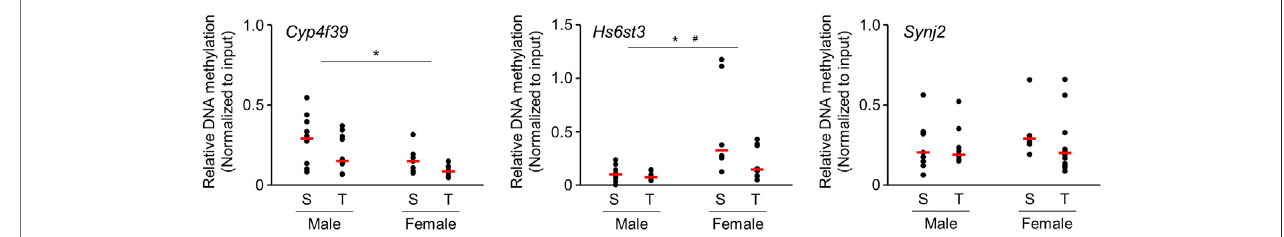
FIGURE4| ScatterplotsofbrainDNAmethylationlevelsof1-day-oldoffspringmicefromTiO 2 -Hand Shamgroupsdetermined byEnrichment ofMethylatedDNA Fragments Followed by qPCR. Methylated DNA fragments were enriched from genomic DNA obtained from each sample {two offspring were randomly selected from eachdam[Sham(S): n (cid:2) 5,TiO 2 -H(T): n (cid:2) 6]}usingMethylCollectorUltraKit(ActiveMotif).Then,methylatedDNAfragmentsweresubjectedtoqPCRanalysis.Two-way ANOVAwithexposureandsexasfactors,followedbypost-hocTukeytest.* p < 0.05:maineffectofTiO 2 -NPexposureonrelativeDNAmethylation; # p < 0.05:main effect of sex on relative DNA methylation (Sham vs.